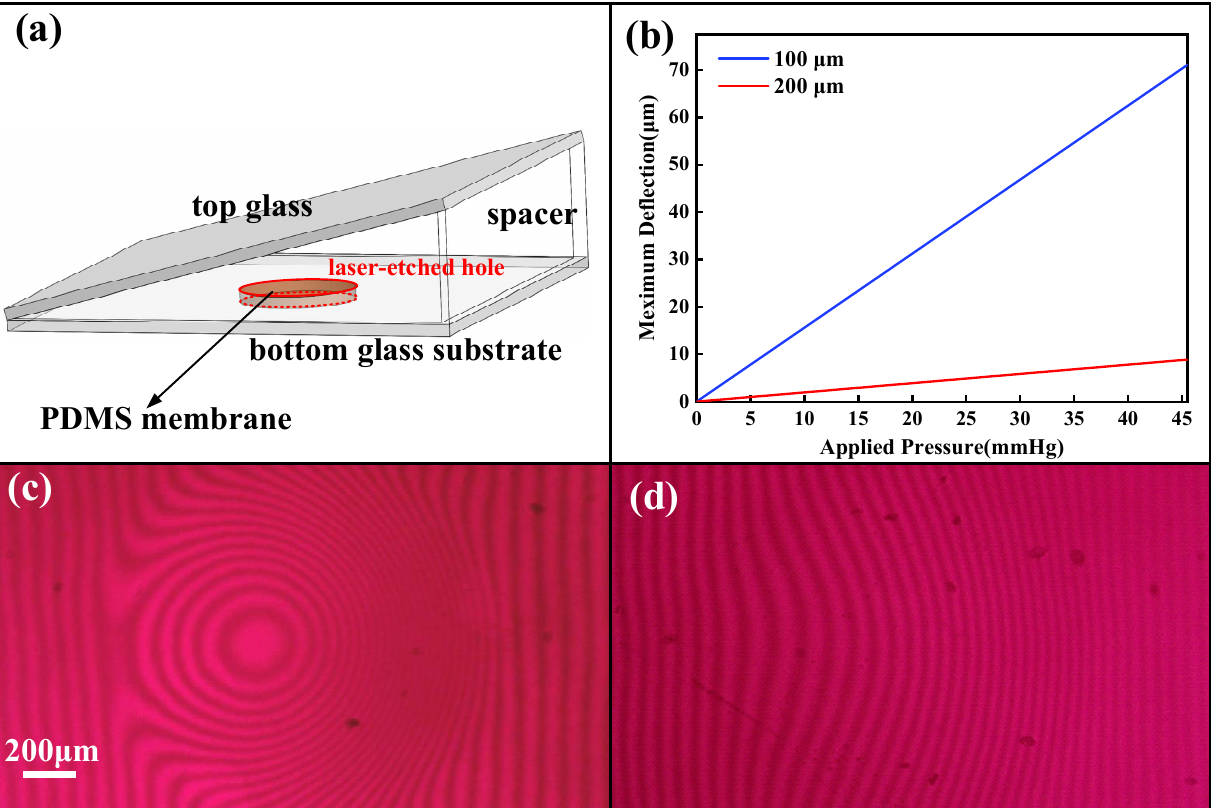
Figure 3. ( a ) The structure of IOP sensor. ( b ) Simulation of 100 μm− and 200 μm−thick membranes deflection under pressure. ( c ) Interference pattern of 100 μm−thick membrane under the pressure of 22.5 mmHg. ( d ) Interference pattern of 200 μm−thick membrane under the same pressure.